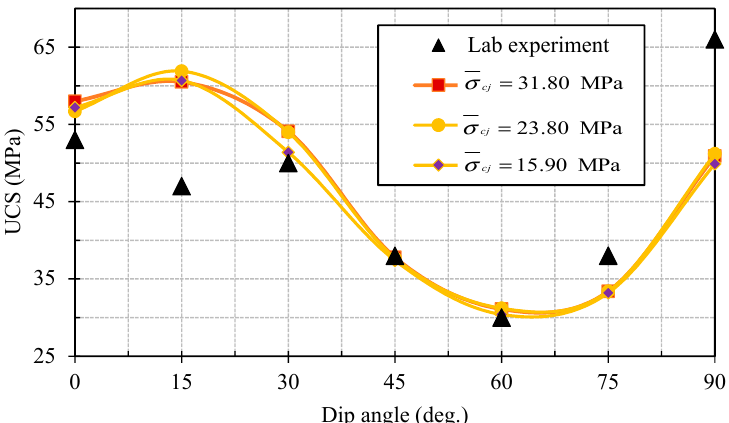
Figure 26. Strength variation of transversely isotropic rock samples with different joint tensile strength.